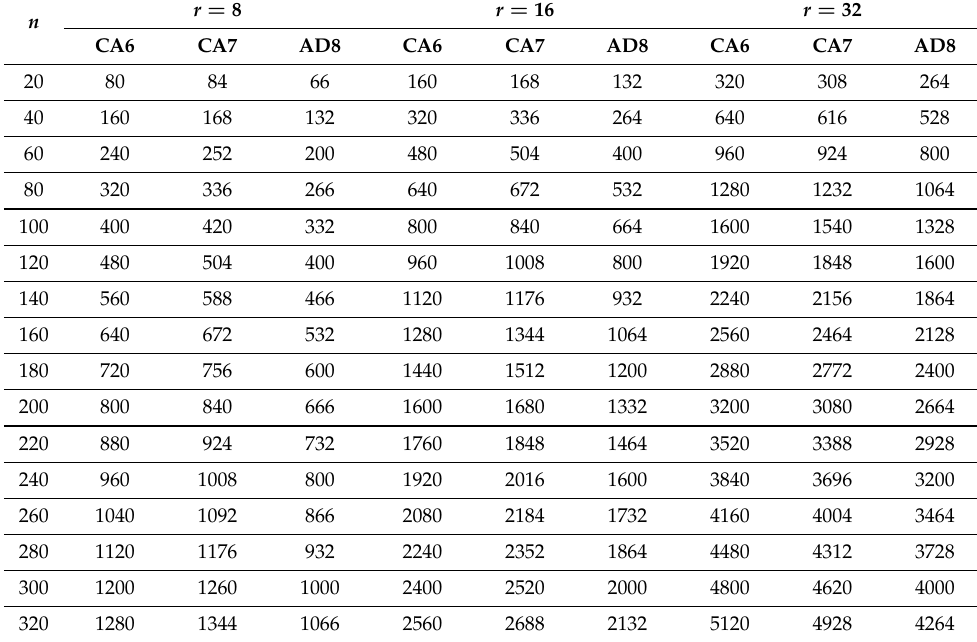
Table 5. Comparison of k r × r presented in [15] and required by Theorem RNB